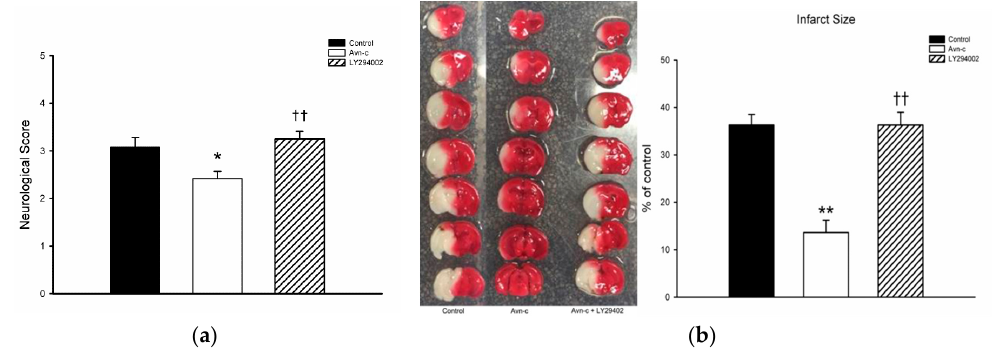
Figure 1. Avn-c treatment improved neurologic function and reduced cerebral infarct volume l: ( a ) Avn-c treatment significantly decreased neurological deficit scores (data from 36 mice, n = 12); ( b ) Representative photographs of TTC-stained brain sections (1 mm) showing the infarction area from MCAo, Avn-c, and Avn-c + LY294002 (PI3K inhibitor) groups at 24 h after MCAo (data from 12 mice, n = 4). Quantitative analysis of infarction size by TTC staining and presented as a percentage of the total brain volume. Data shown are the mean ± SEM. * p < 0.05 and ** p < 0.01 vs. Control group, †† p < 0.01 vs. Avn-c group.